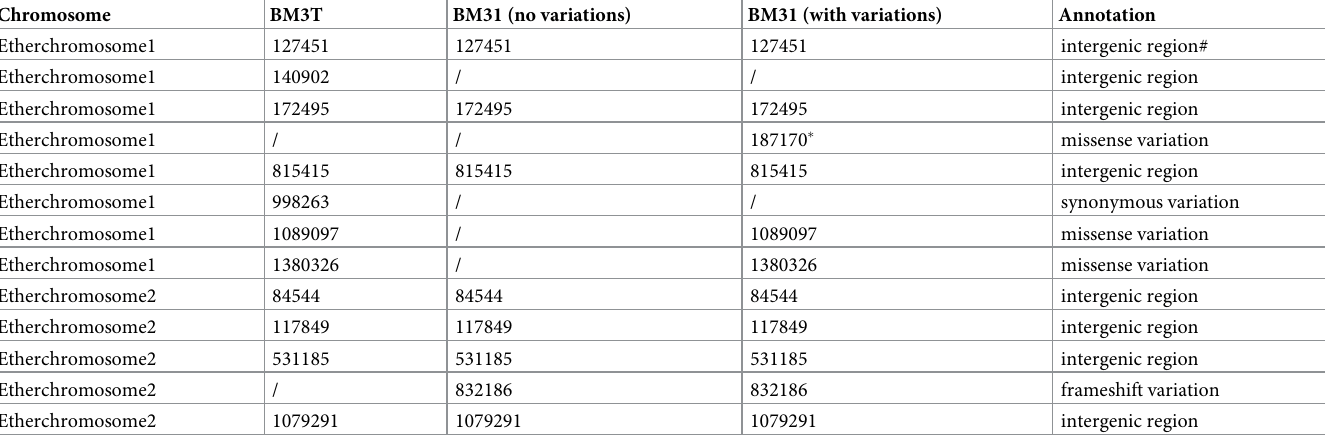
Table 1. SNPs in B . melitensis under low-level rifampicin and normal media. Chromosome